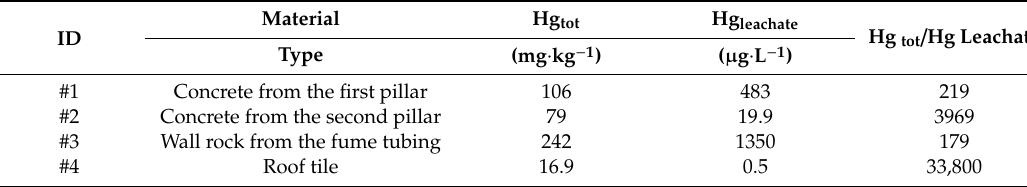
Table 1. Total (in mg · kg − 1 ) and leachable (in 1350 µ g · L − 1 ) mercury and total-Hg / leachable-Hg ratio for the four studied